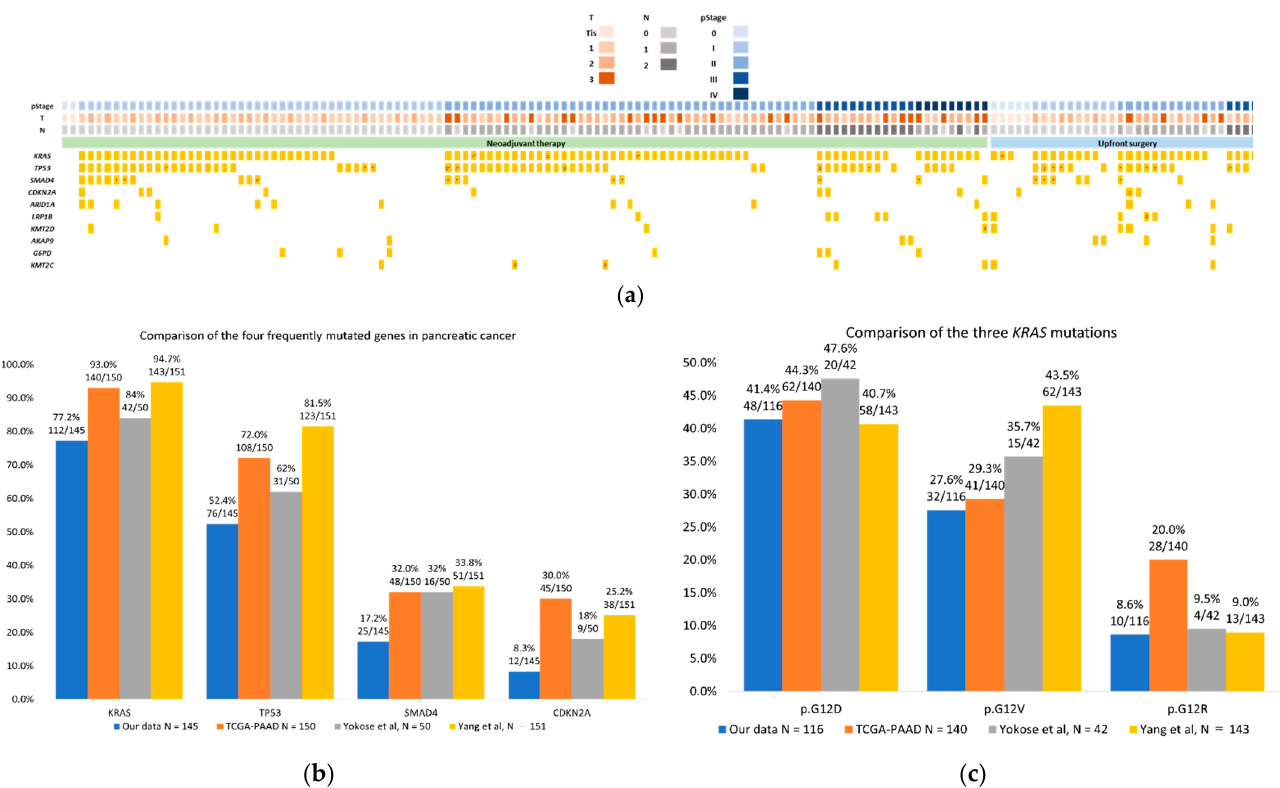
Figure 2. Genomic landscape of pancreatic cancer using Comprehensive Cancer Panel. ( a ) Genomic landscape of the 10 most commonly mutated genes in tumor tissue using next-generation sequencing (NGS) in pancreatic cancer. The clinical characteristics of patients are represented by the tiles at the top of the oncoplot, with details stated in the legend. KRAS , TP53 , and SMAD4 represent hotspot mutations in the liquid biopsy panel. Asterisk indicates the presence of mutations other than hotspot mutations (detected only in the tumor panel). The percentages of patients harboring KRAS , TP53 , and SMAD4 hotspot mutations were 77.2% (112/145), 44.1% (64/145), and 4.8% (7/145), respectively. All mutations below CDKN2A are mutations detected only in the tumor panel. ( b ) Comparison of gene mutation rates in tumor tissue against The Cancer Genome Atlas (TCGA) data and the two Asian datasets. Four mutated genes known to be commonly mutated in pancreatic cancer are shown. N indicates the number of patients. ( c ) Comparison of types of KRAS mutation rates in tumor tissue against TCGA data and the two Asian populations. Only the 3 most common mutations are shown. N indicates the number of mutations.